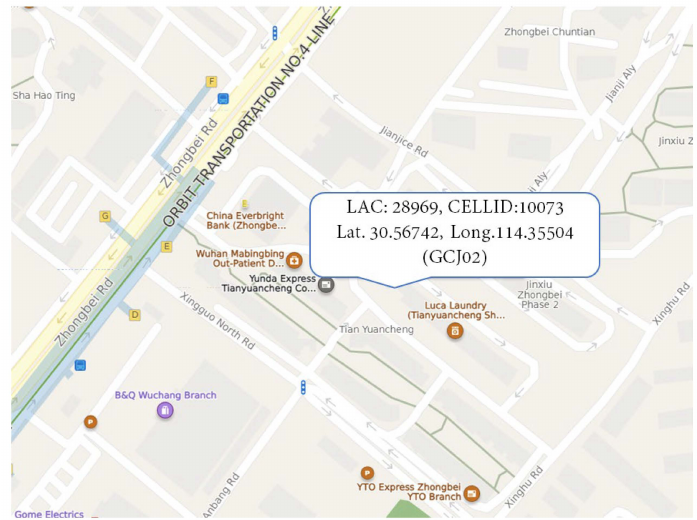
Figure 4. Schematic diagram of base station